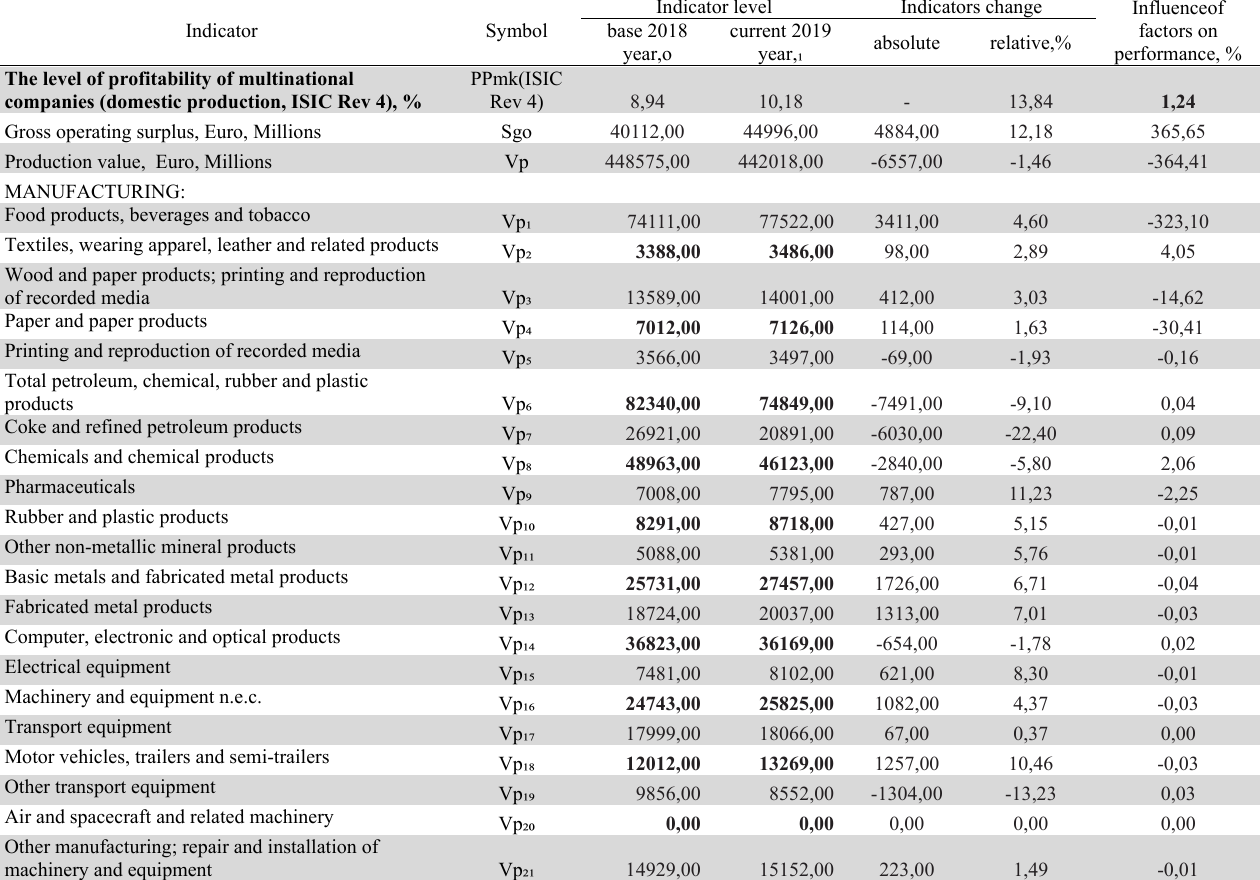
Indicator level Indicators change Influenceof factors on base 2018 absolute relative,% performance, % year, о